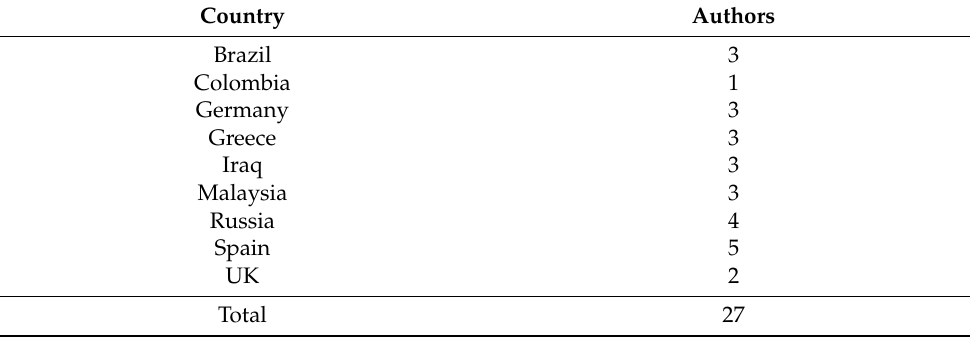
Table 1. Authors’ countries: statistics.